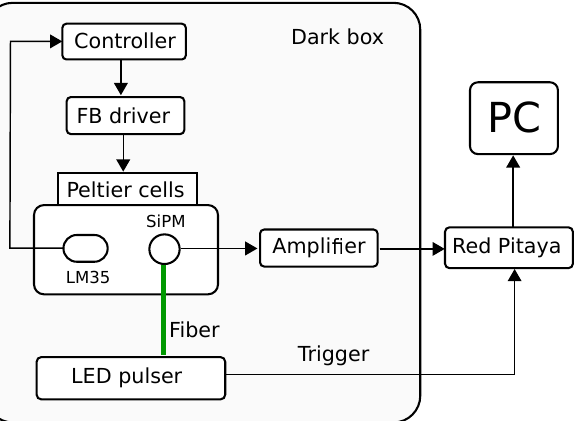
Figure 2. Experimental setup for measuring the gain and noise of the SiPM under stimulated conditions. The SiPM is stimulated by a 480nm pulsed light of ∼ 10ns width at 500Hz. The SiPM signal is digitized by the Red Pitaya at